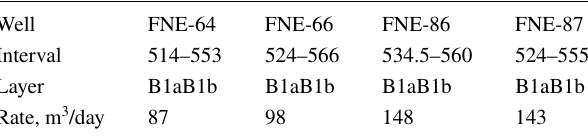
Table 17 Injection rate of injectors in recommended case